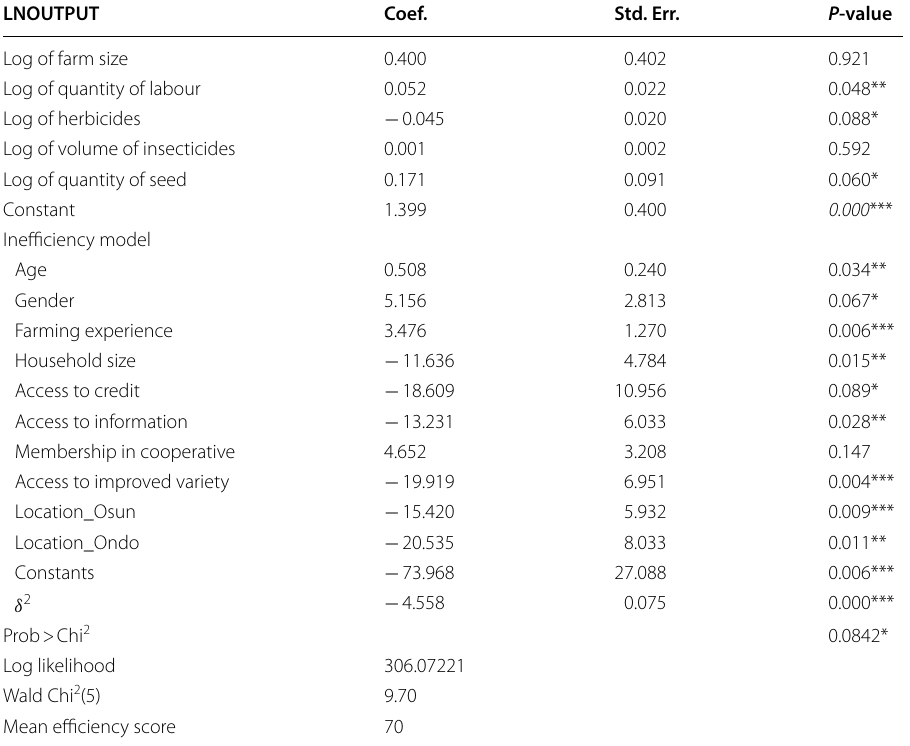
Table 3 Maximum likelihood estimates for parameters of the stochastic frontier production models for rice